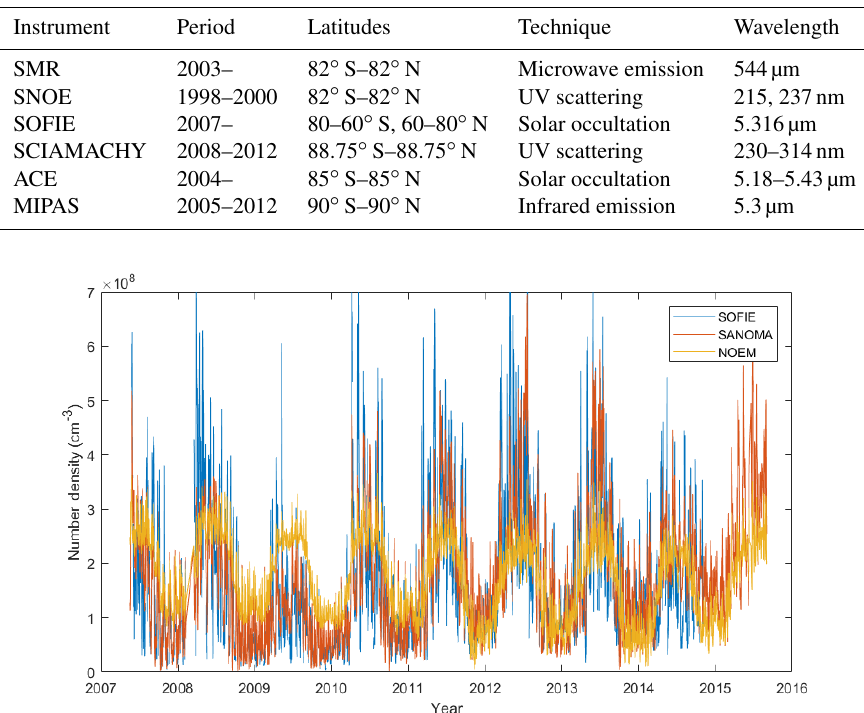
Figure 13. Time series of NO number density measured with SOFIE over the entire measurement period as well as simulated NO with SANOMA and NOEM, 102km altitude, − 70 ◦ (cid:51) .